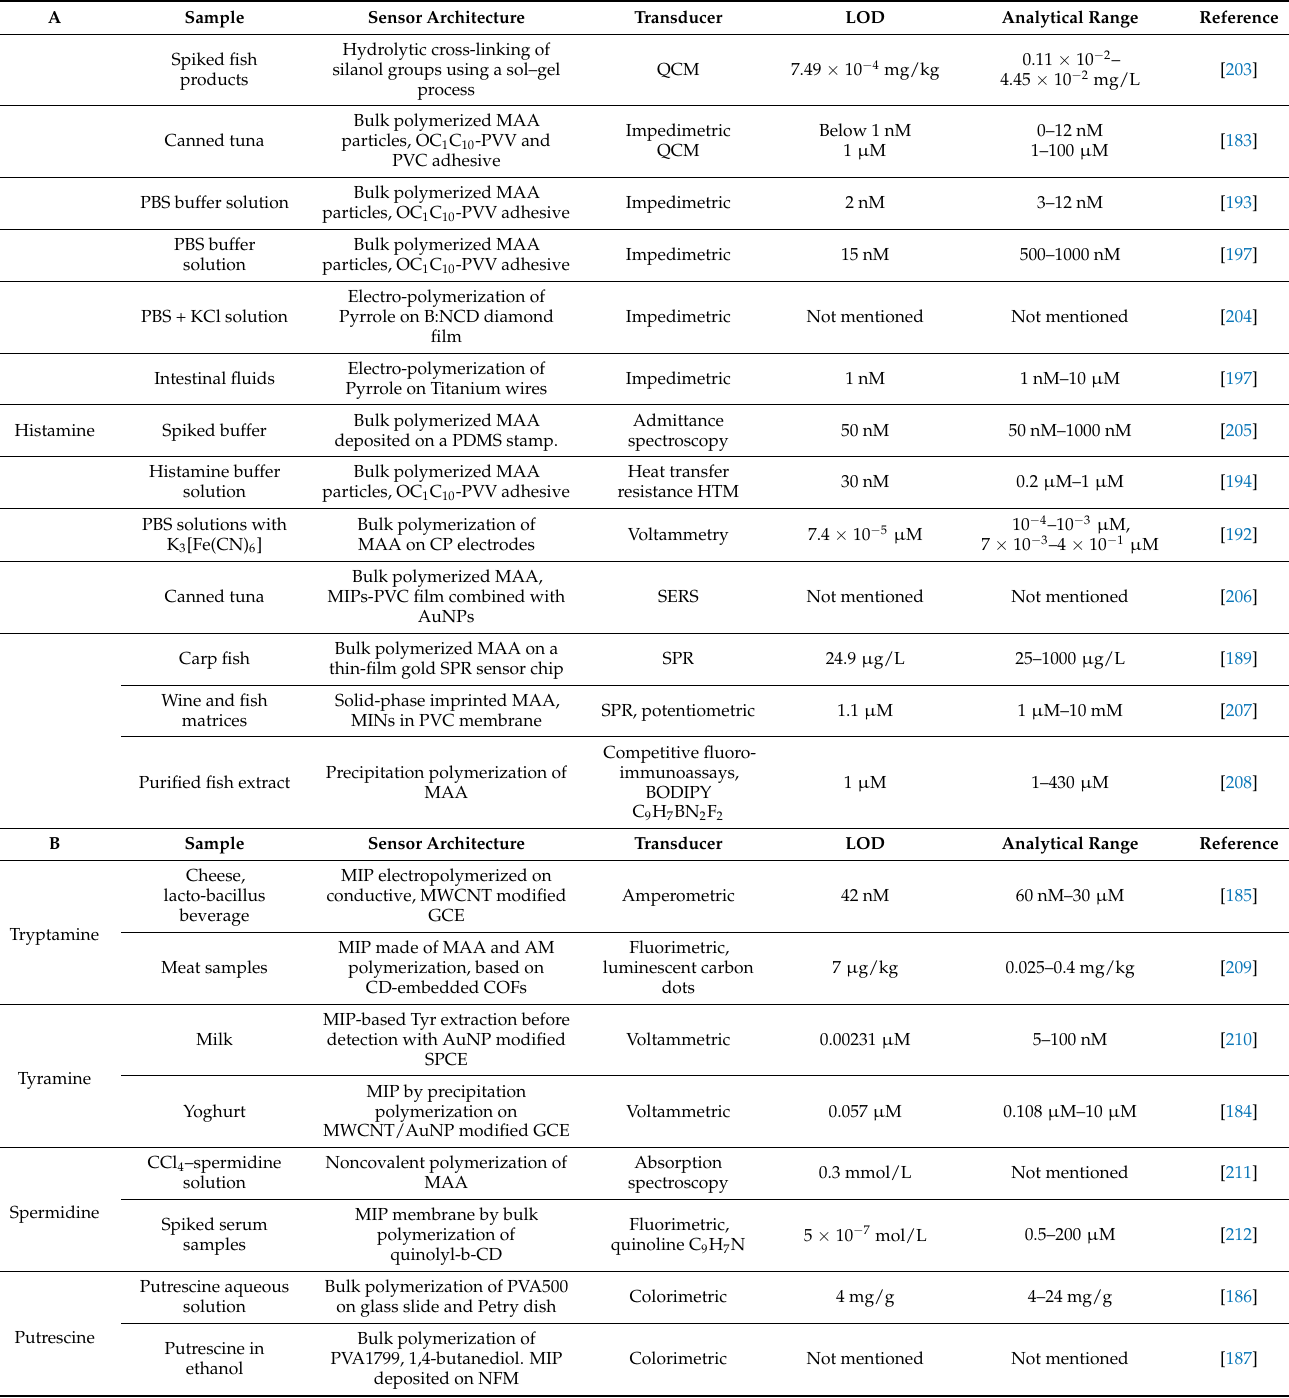
Table 3. Overview of selected BA sensors using molecularly imprinted polymers as selective recog- nition elements. While the table is not exhaustive, it is evident that MIPs are highly versatile, and the limits of detection are remarkably lower than in the case of the commercially available fast tests for histamine discussed in Section 5.4. While A summarizes the sensors for histamine detection, B reviews the publications on sensors for various other biogenic